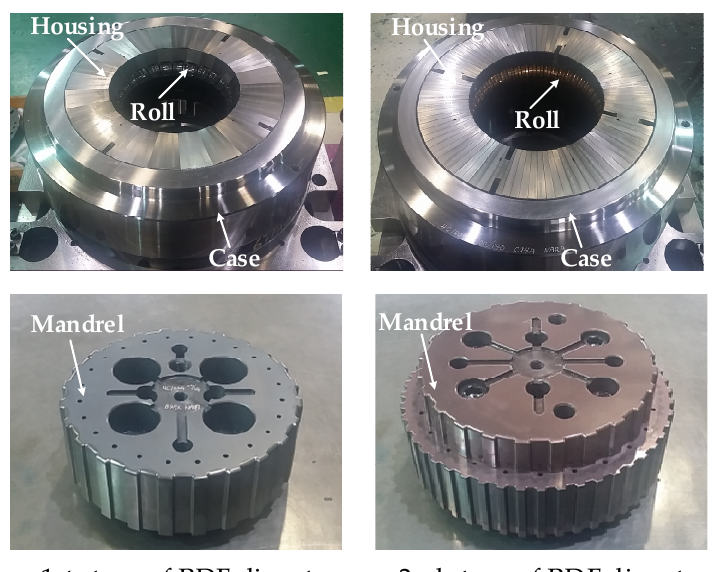
Figure 11. Result of structural simulation of the rolls of the 2nd RDF process.